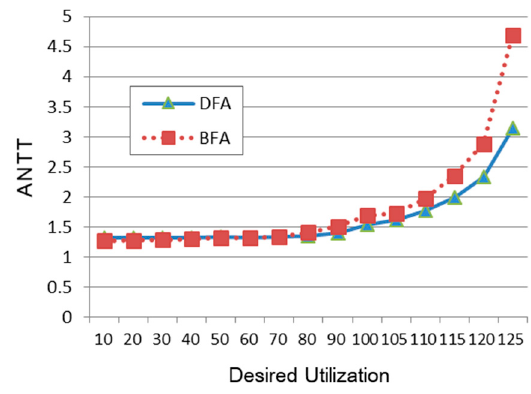
Figure 8. Performance comparison under workloads of uniform resource demand.